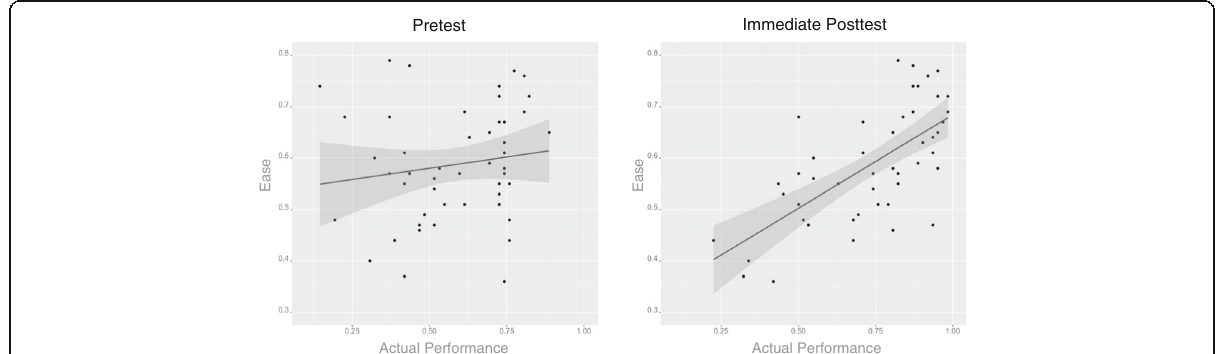
Fig. 7 The scatter plots depicting the correlation between the Ease value and the actual performance in pretest and immediate post-test of each of the 48 items used in